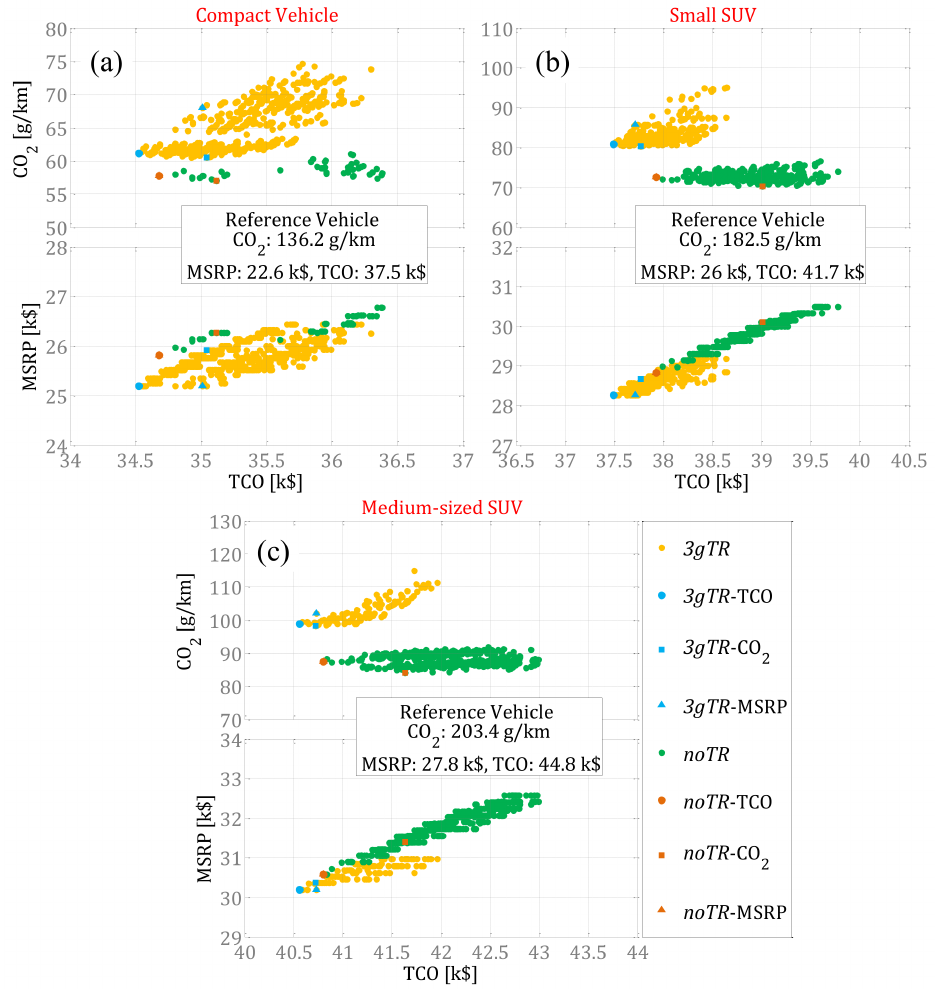
Figure 4. CO 2 emissions (top) and MSRP (bottom) versus the TCO for the feasible designs of the three vehicle segments ( a – c ) and two layouts ( 3gTR in yellow, noTR in green), over the 1015